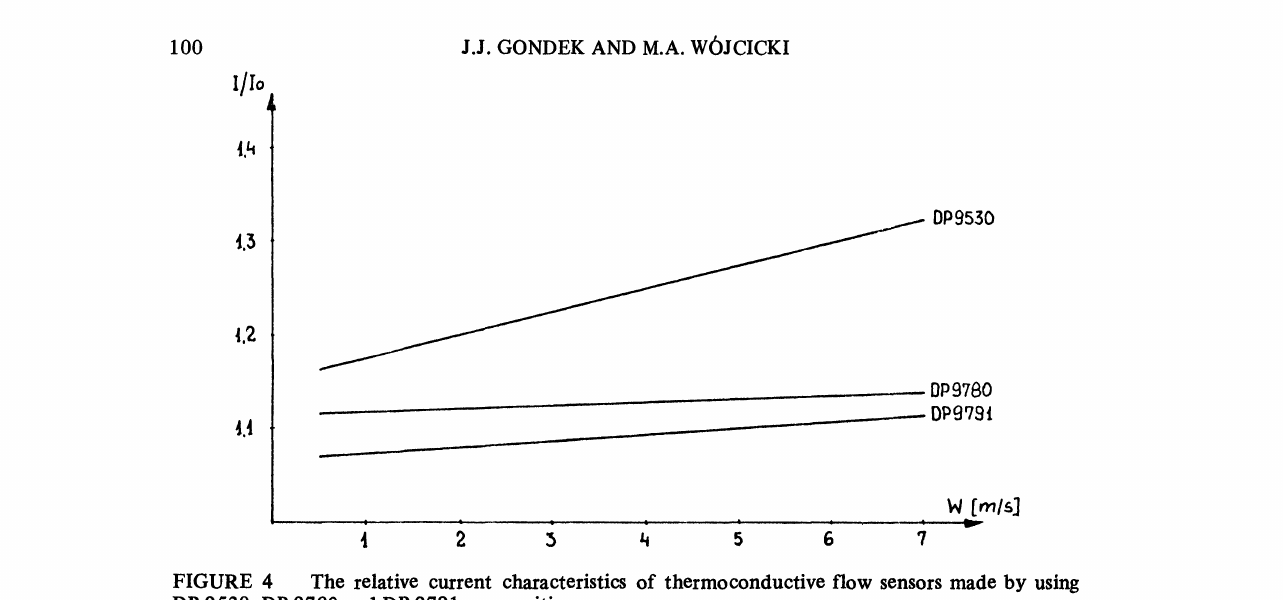
The relative current characteristics of thermoconductive flow sensors made by using DP 9530, DP 9780 and DP 9791 compositions.